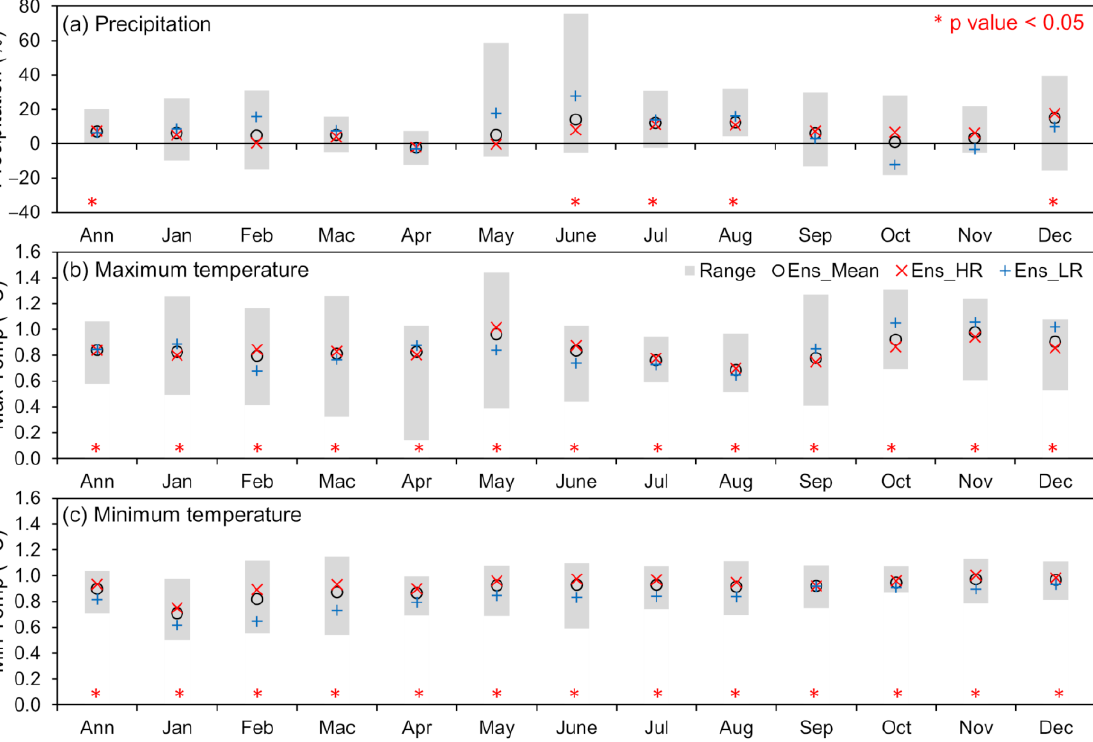
Figure 5. Projected changes of ( a ) precipitation, ( b ) maximum and ( c ) minimum temperatures between 1985–2014 and 2021–2050 in the Kelantan River Basin, Malaysia.